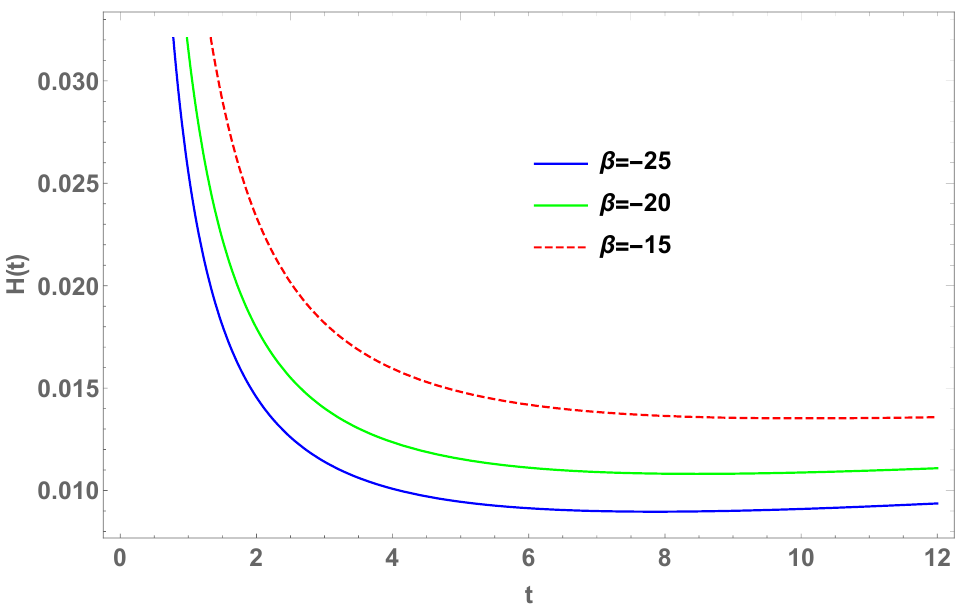
Figure 6. Behaviour of the Hubble parameter ( H ) with respect to cosmic time t for different values of β with γ = 1.65, k = 0.25.